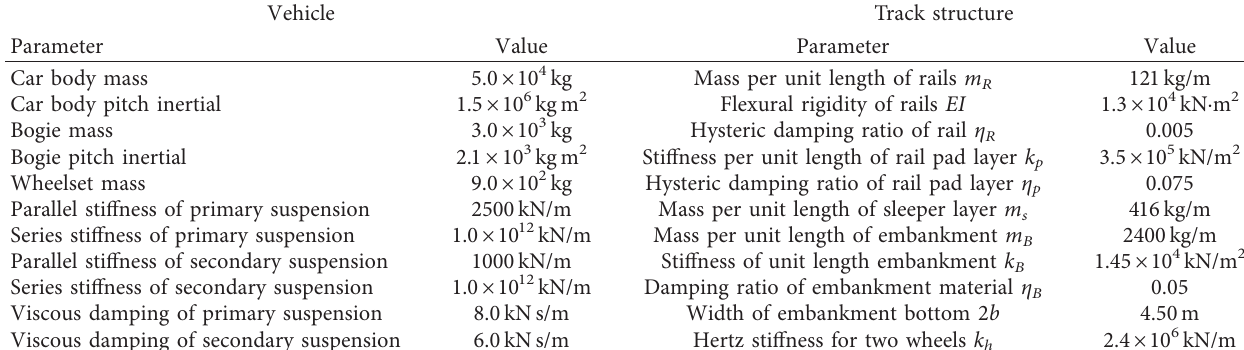
Table 1: Model parameters of train and track for Beijing Urban Rail Line